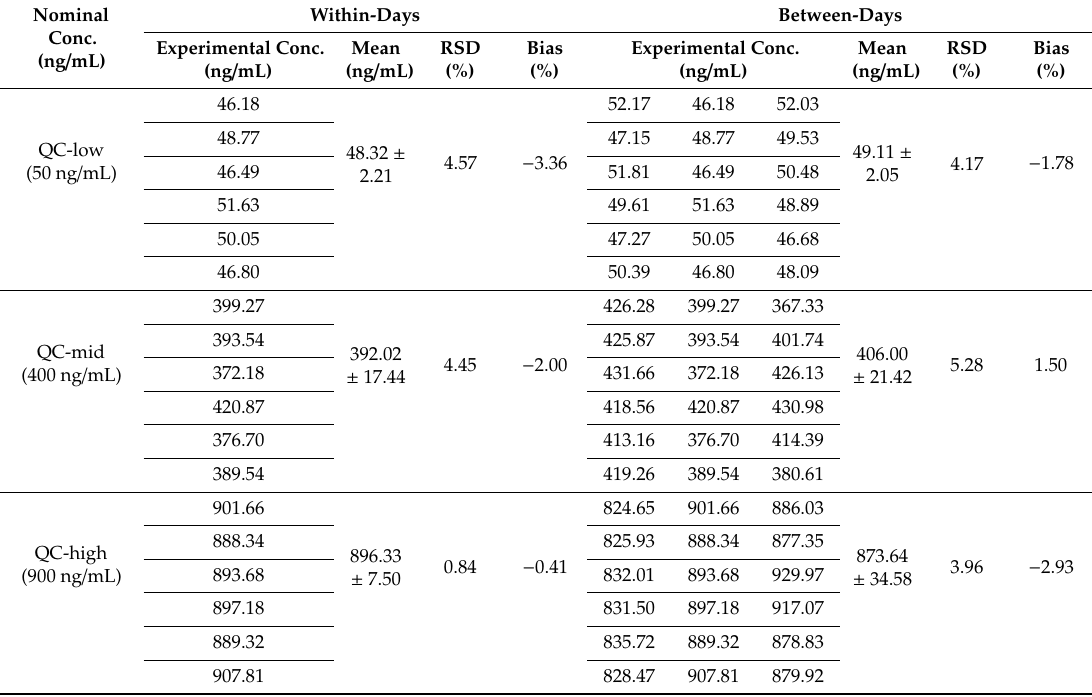
Table 4. Within- and between-day accuracy and precision of HPLC analytical method, expressed as RSD (%) and bias (%) ( n = 6 and 18 for within-days and between-days, respectively). Nominal Within-Days Conc.